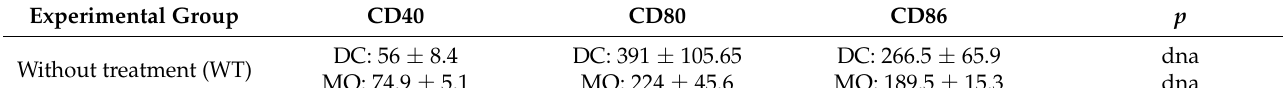
Table 1. Expression of costimulatory molecules in DC and macrophages. The expression of each costimulatory molecule is represented by the average of the mean fluorescence intensity (MIF)